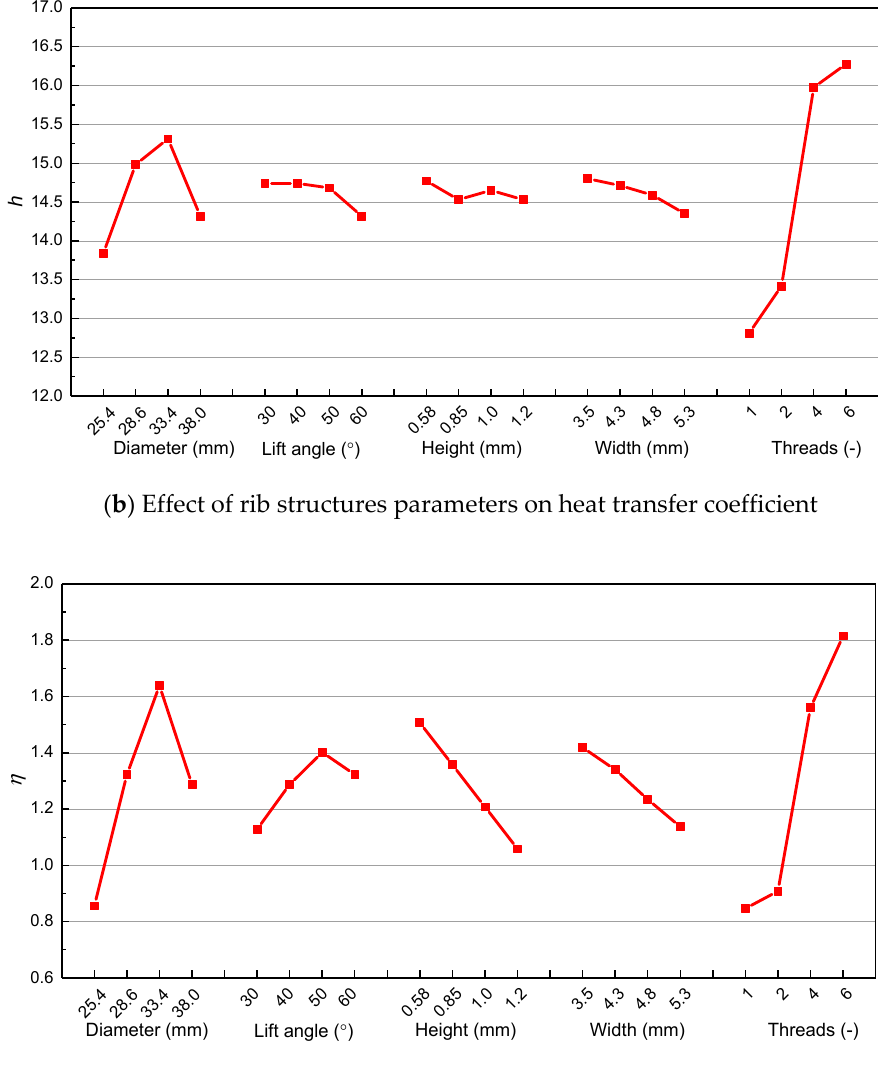
( c ) Effect of rib structures parameters on performance evalution criteria Figure 13. Effect of rib structures parameters on flow and heat transfer. Figure 13. Effect of rib structures parameters on flow and heat